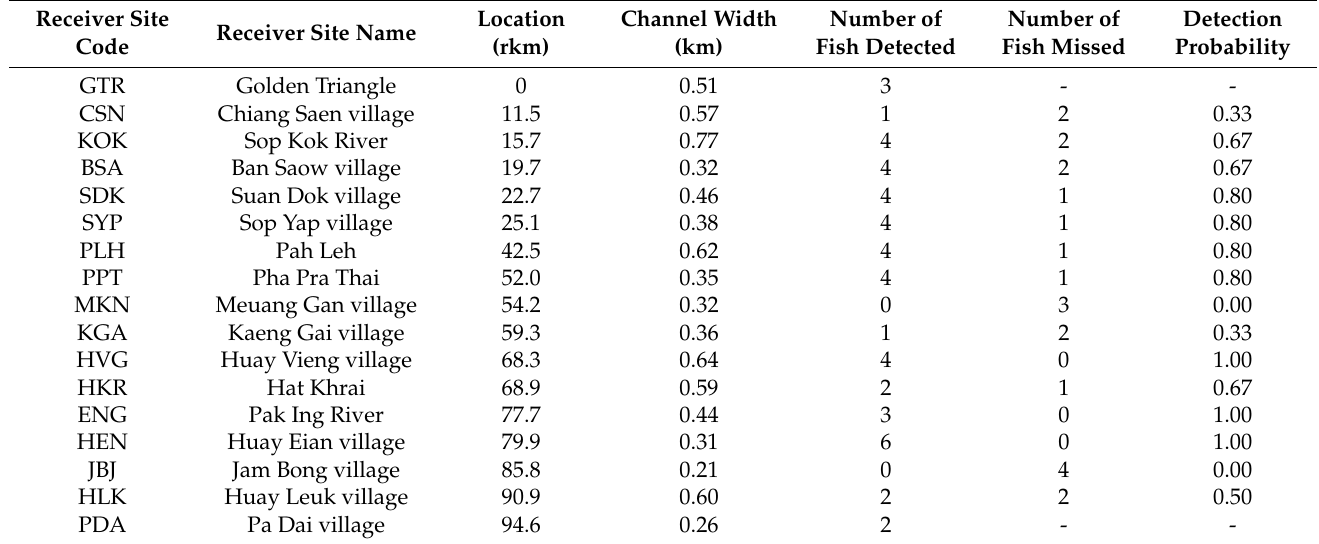
Table 1. Locations and detection probabilities of receivers used to monitor movements of acoustic-tagged catfishes in the Mekong River, northern Thailand, from May 2006 to May